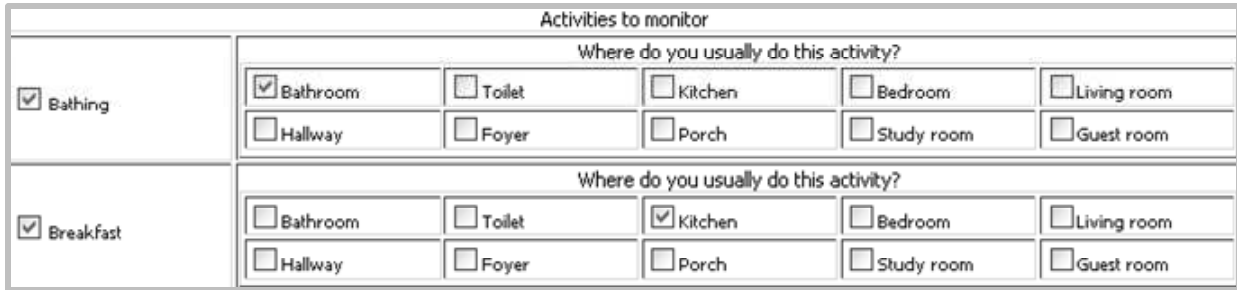
Figure 3. Testbed configuration: activity selection